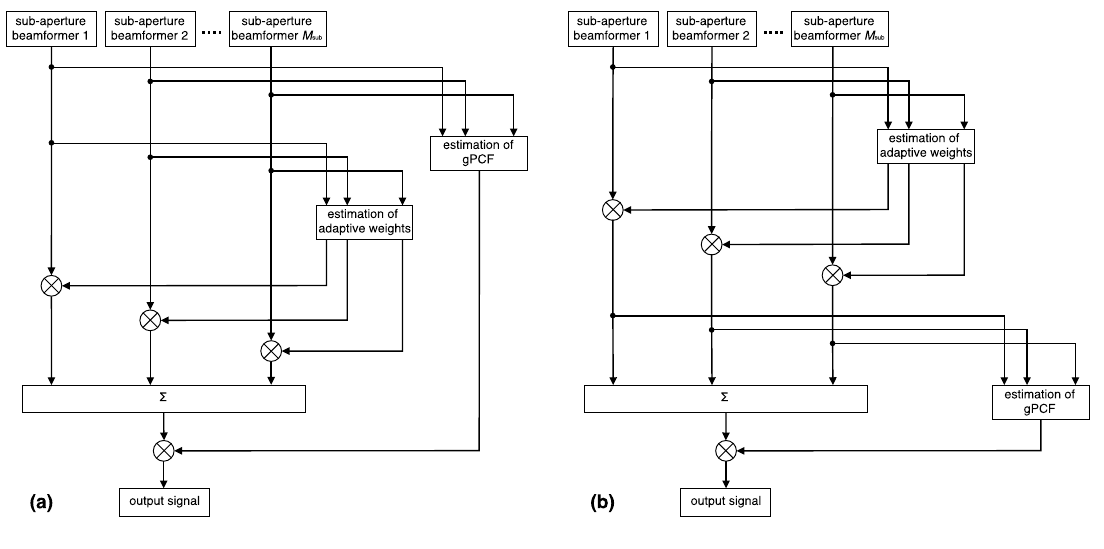
Figure 1. Illustration of weighting procedure using Gaussian Phase Coherence Factor (gPCF) estimated ( a ) before and ( b ) after applying adaptive beamformer weights to outputs of sub-aperture